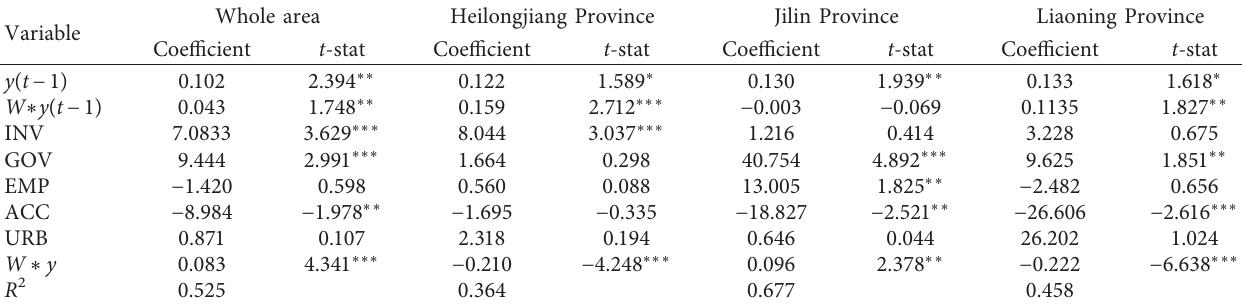
Table 4: Dynamic model